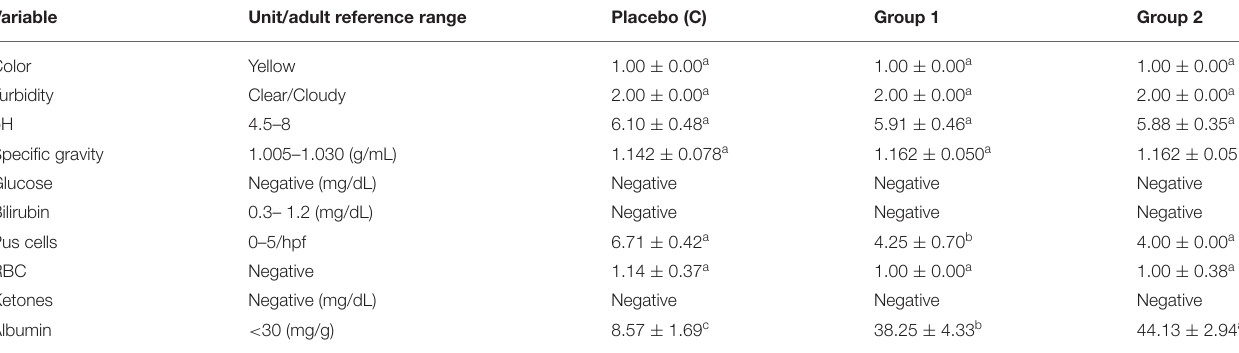
TABLE 5 | Urine biochemical assessment of the participants.